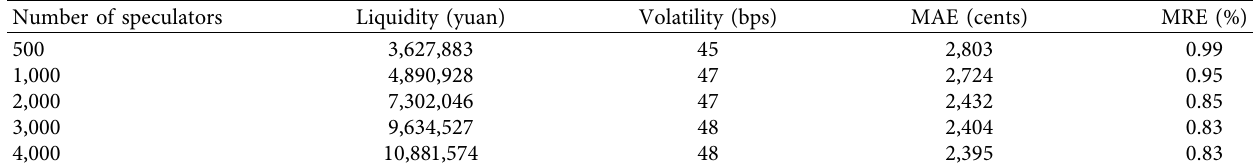
Table 10: Impact of speculators of the stock index futures